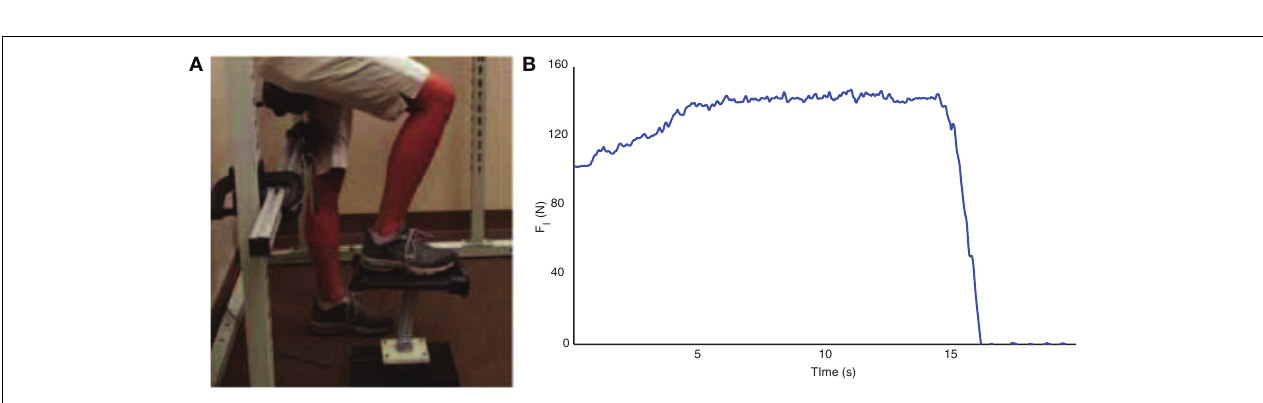
FIGURE 1 |The SD test (A) consists of compressing a compliant, slender spring prone to buckling, and sustaining the maximal level of compression for > 5s .The pulps of the thumb and index finger press against